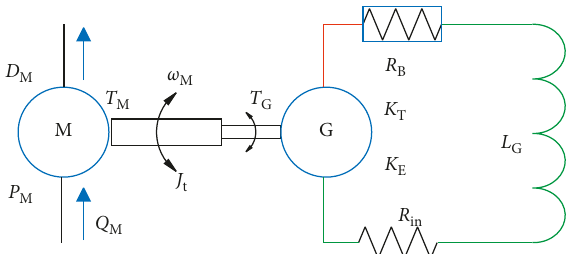
Figure 4: Schematic view of energy conversion (mechanical to electrical) and power